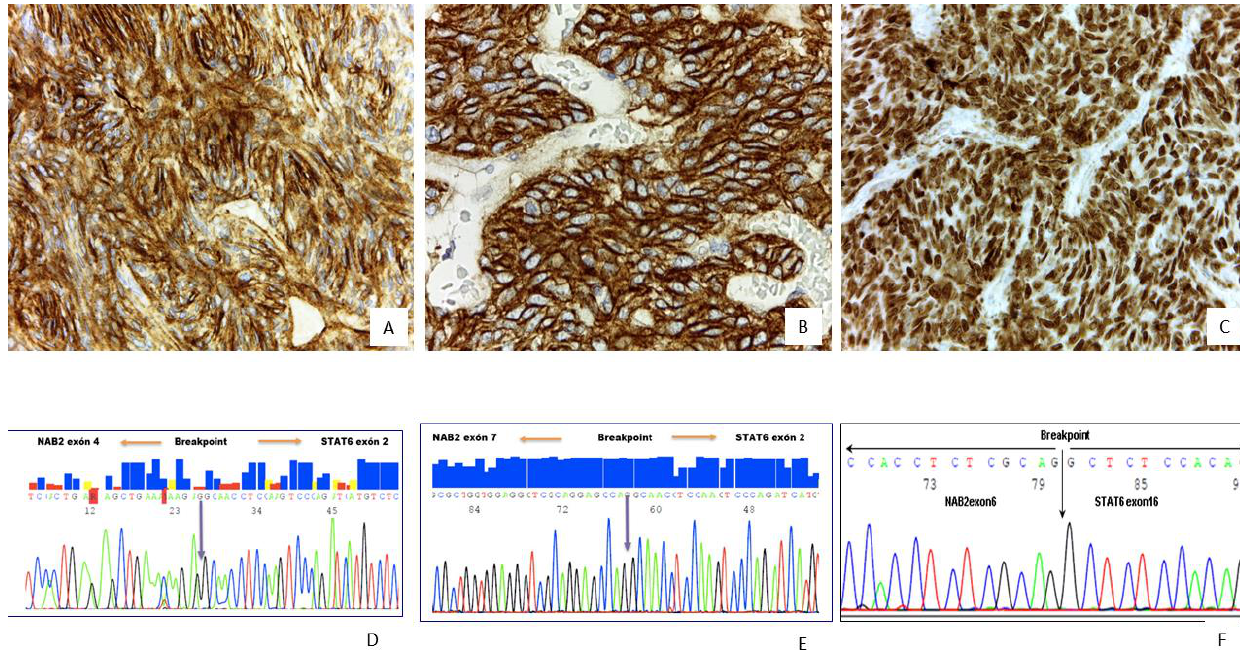
Figure 2. ( A ) Diffuse and strong CD34 positivity in tumor cells in SFT, 40 × . ( B ) Diffuse (membranous) CD99 immunoreac- tivity in tumor cells in SFT, 40 × . ( C ) Diffuse and strong nuclear STAT6 positivity in tumor cells of SFT, 40 × . ( D – F ) Molecular analysis in three different SFT cases with NAB2/STAT6 gene fusion; the breakpoints were NAB2 exon 4-STAT6 exon 2 , NAB2 exon 7-STAT6 exon 2 and NAB2 exon 6-STAT6 exon 16) respectively.